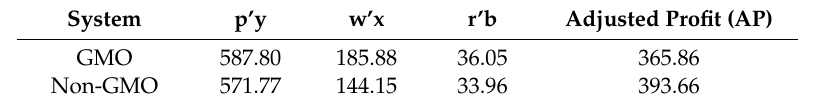
Table 7. Adjusted profit for GMO and non-GMO rice systems if the quantity for GMOs is raised 10%.